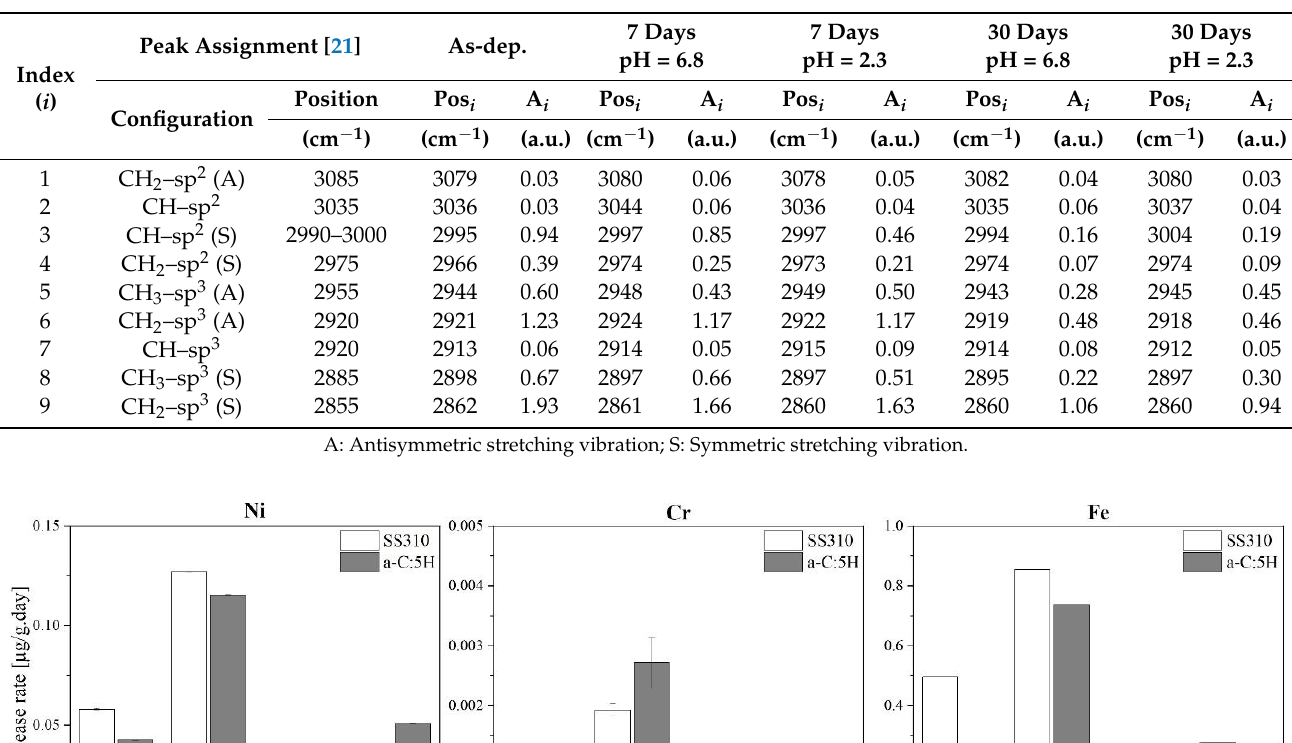
Table 5. FTIR peak fitting results of vibrational frequency assignments of as-deposited and as-immersed a-C:H coatings: peak positions (Pos i ) and areas (A i ).